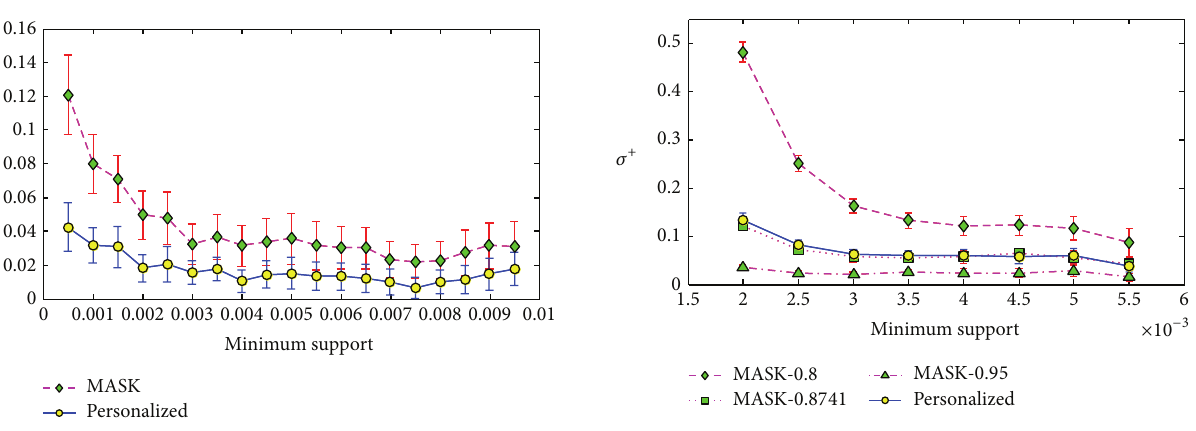
Figure 8: Frequent itemset added ration 𝜎 + versus minimum support on BMS-WebView-1x10.